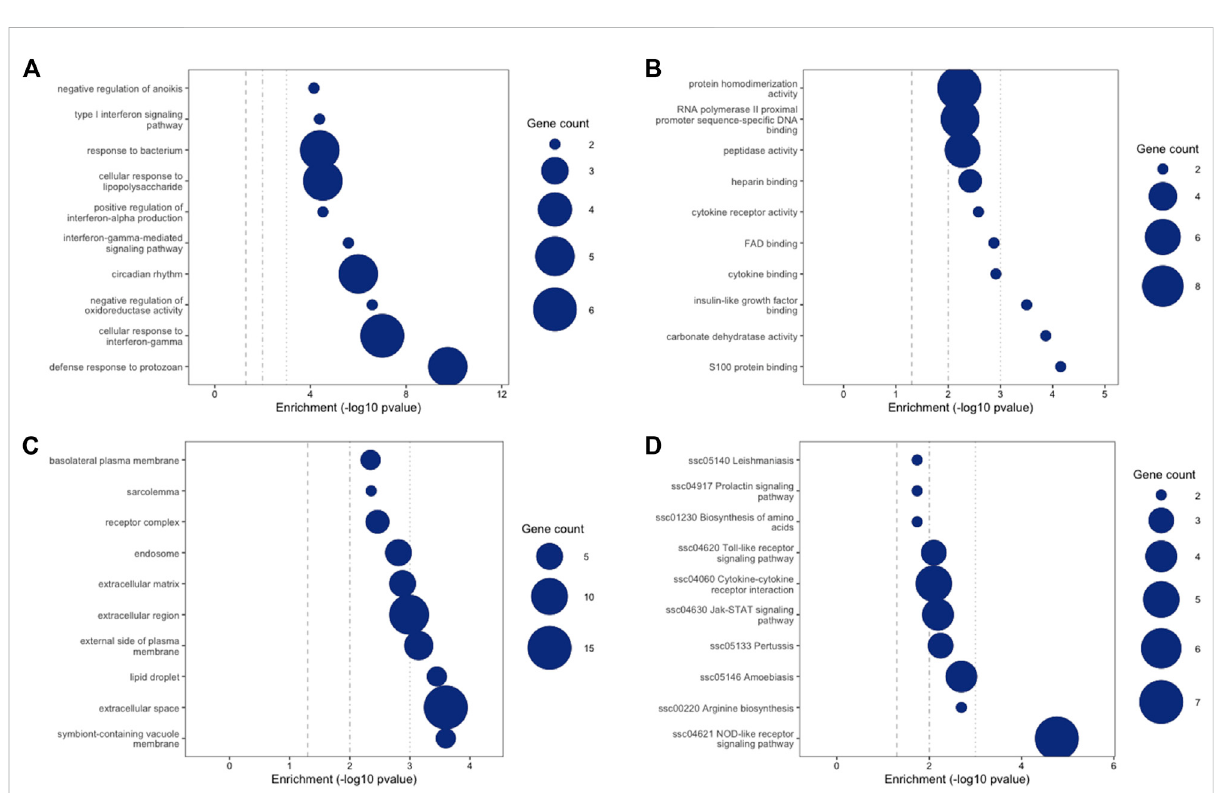
FIGURE 5 Gene ontology (GO) and KEGG pathway enrichment analysis showing top 10 enriched terms between weaned and unweaned pigs (all time points).Sizeofcirclesrepresentsnumberofgeneineachterm. (A) GOBiologicalProcess, (B) GOMolecularFunction, (C) GOCellularCompartment, (D)